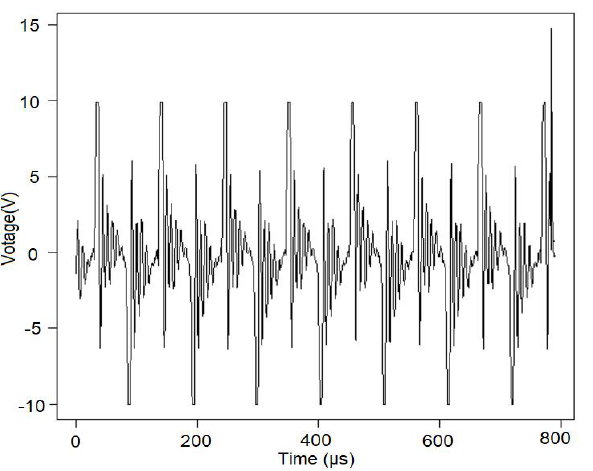
Figure 1. The experimental setup [20].